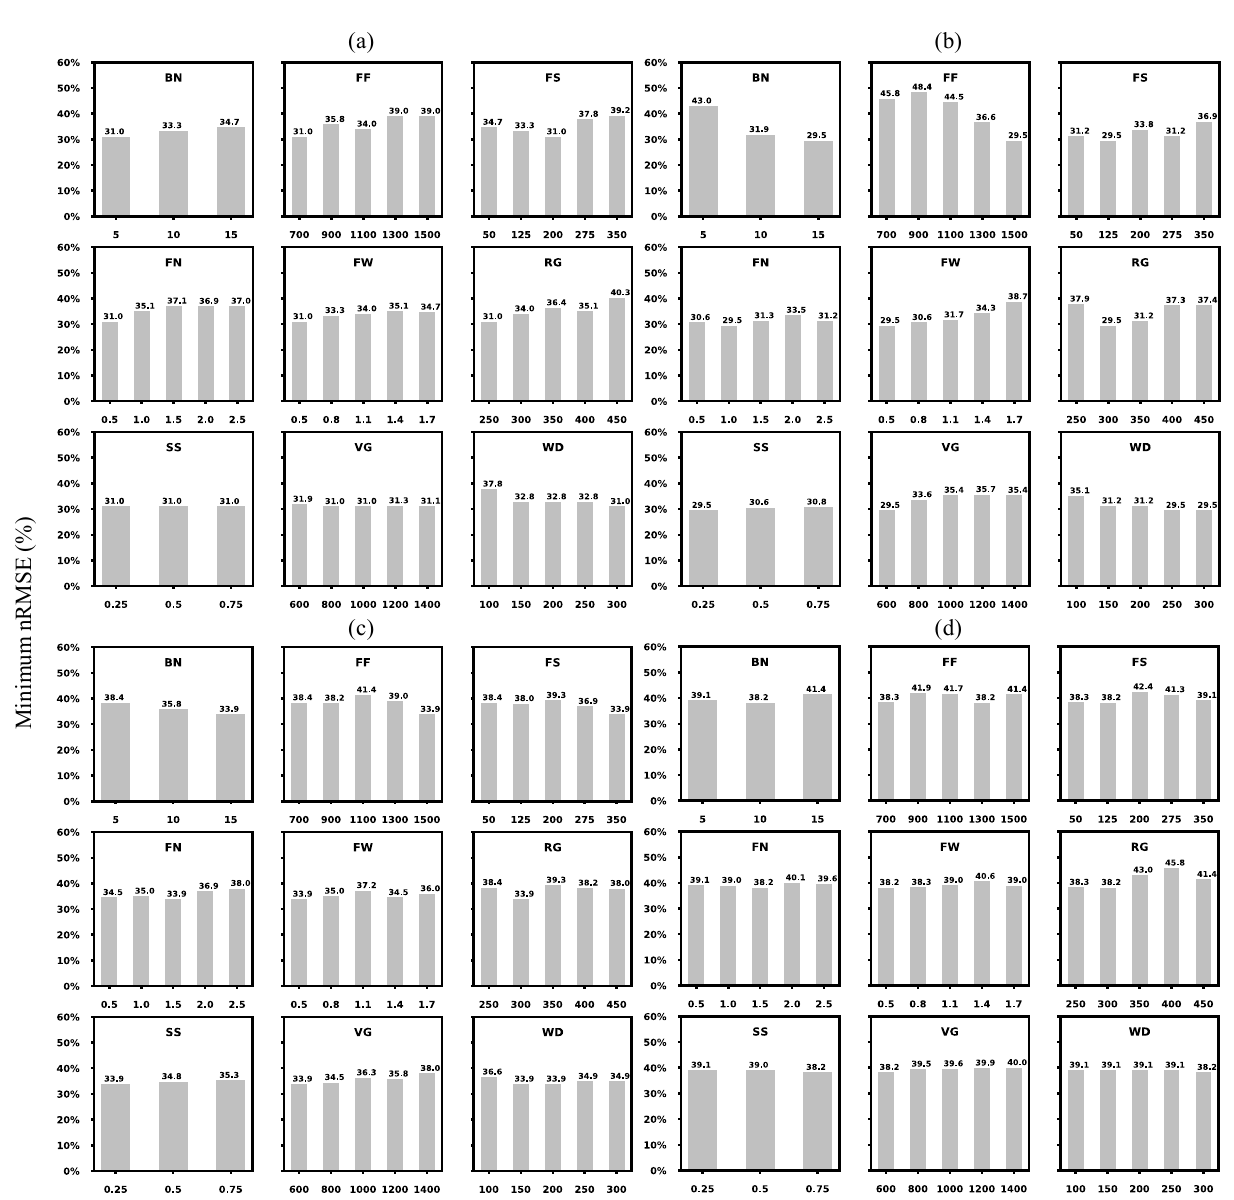
Figure 2. Minimum value of the STICS model prediction uncertainties (nRMSE, %) based on the combined variable (i.e., objective function) under each parameter value (fix a given parameter value and test the remaining combinations). ( a ) Touriga Nacional (TN) with the single-cordon training system; ( b ) Touriga Nacional (TN) with the double-cordon training system; ( c ) Touriga Franca (TF) with the single-cordon training system; ( d ) Touriga Franca (TF) with the double-cordon training system. The parameter abbreviations are denoted for each subplot (see Table 2 for detailed parameter descriptions). The associated boxplots are shown in Figures S2–S5. The calibrated parameters are BN: Box number; FF: Fruit filling thermal requirement; FS: Fruit setting thermal requirement; FN: Fruit number formation potential per degree day − 1 per cluster; FW: Fruit (berry) weight potential; RG: Thermal requirement between budbreak and reproductive onset; SS: Source sink ratio threshold; VG: Thermal requirement between juvenile onset and veraison onset; WD: Thermal requirement between reproductive onset and fruit water dynamic onset.